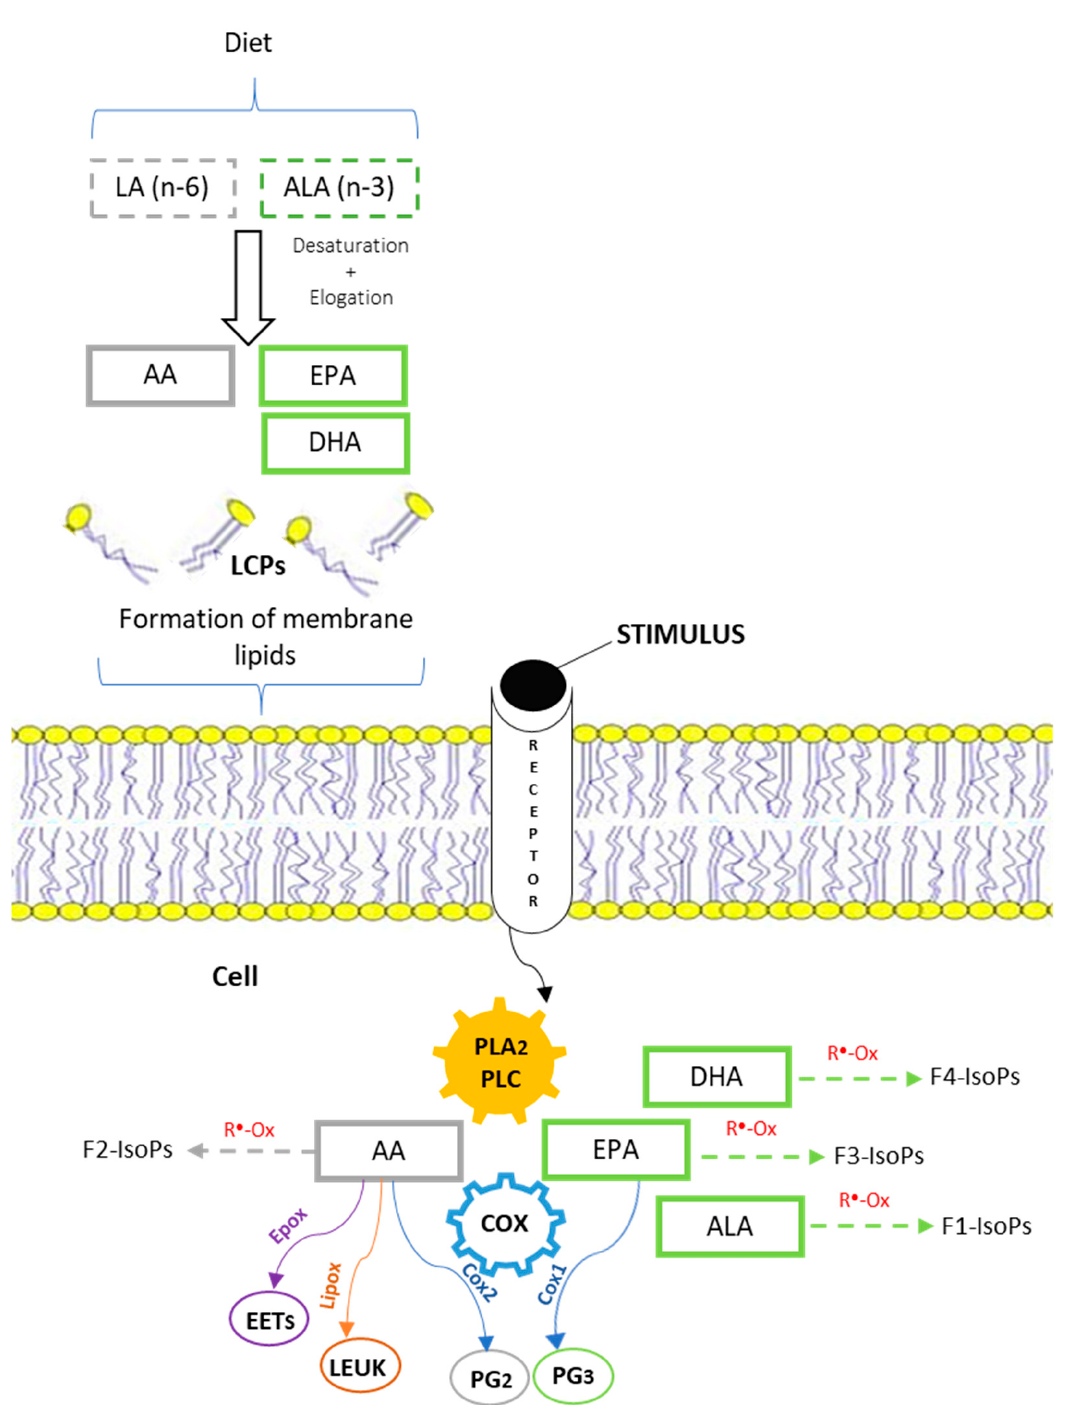
Figure 3. Schematic representation of PUFA metabolism, PGs, and IsoPs synthesis. The n-3 and n-6 precursors (ALA and LA) from the diet through desaturation and elongation processes form LC-PUFA: AA (n-6), EPA, and DHA (n-3). The LC-PUFA are incorporated into the phospholipids of plasma membrane. When external stimuli occur, the PLA 2 and PLC cleave phospholipids to increase the cell availability of AA, EPA, ALA, and DHA. The AA is processed by the COX 2 enzyme to form PG 2 , or by epoxygenase and lipoxygenase to form epoxyeicosatrienoic acids (EETs) and leukotrienes (LEUK). The EPA is involved in the PG 3 synthesis by the COX 1 enzyme. Free radical peroxidation of LC-PUFA generates different classes of IsoPs. F 2 -IsoPs derive from AA oxidation, while F 1 , F 3 , and F 4 -ISoPs from ALA, EPA, and DHA, respectively.